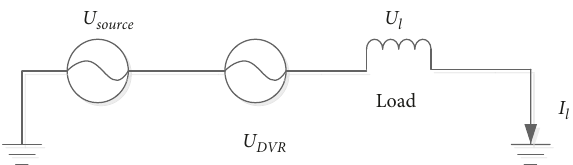
Figure 8: The equivalent circuit of the single-phase DVR